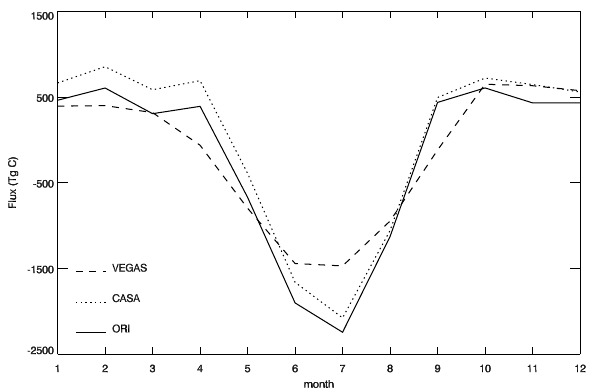
Fig.2. Spatial distribution of difference between terrestrial exchange from CASA and fluxes from VEGAS in January 2006 (positive values denote the fluxes from VEGAS are greater than the fluxes from CASA)